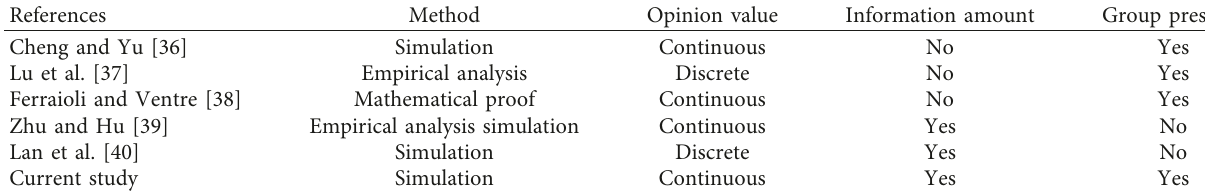
Table 1: Comparison of related studies of public opinion on the impact of group pressure and agent information amount.